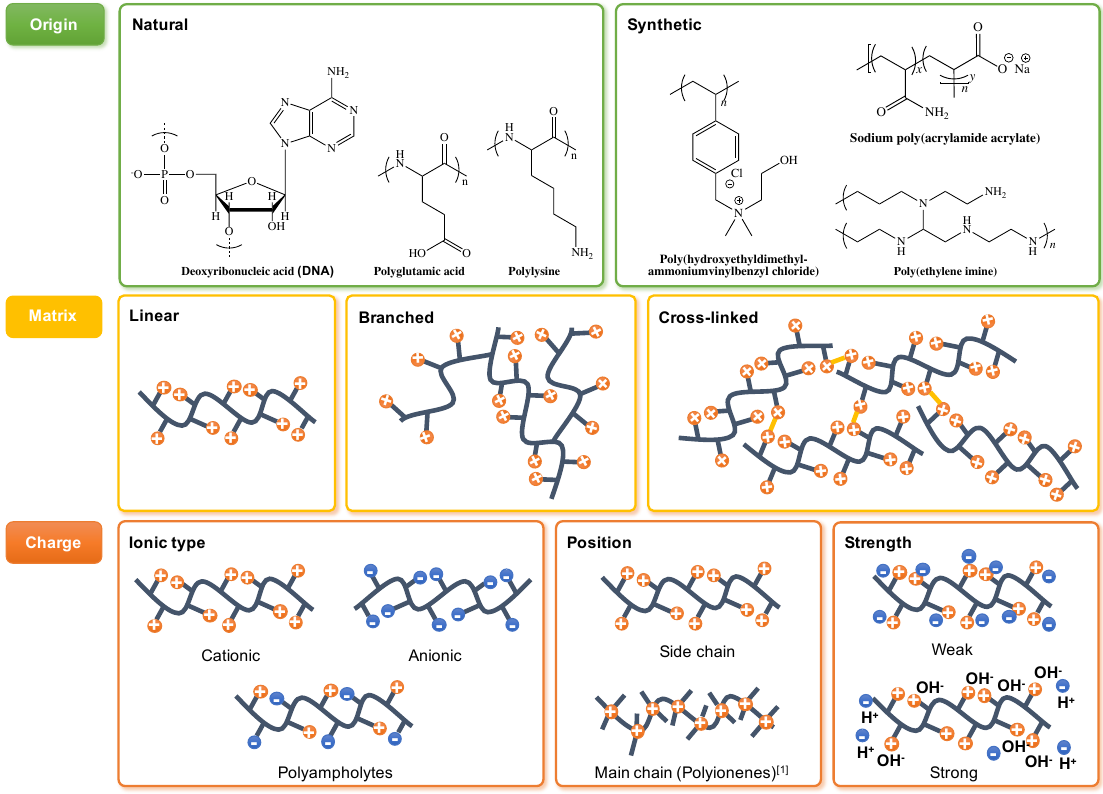
Figure 3. Origin, matrix, and charge in